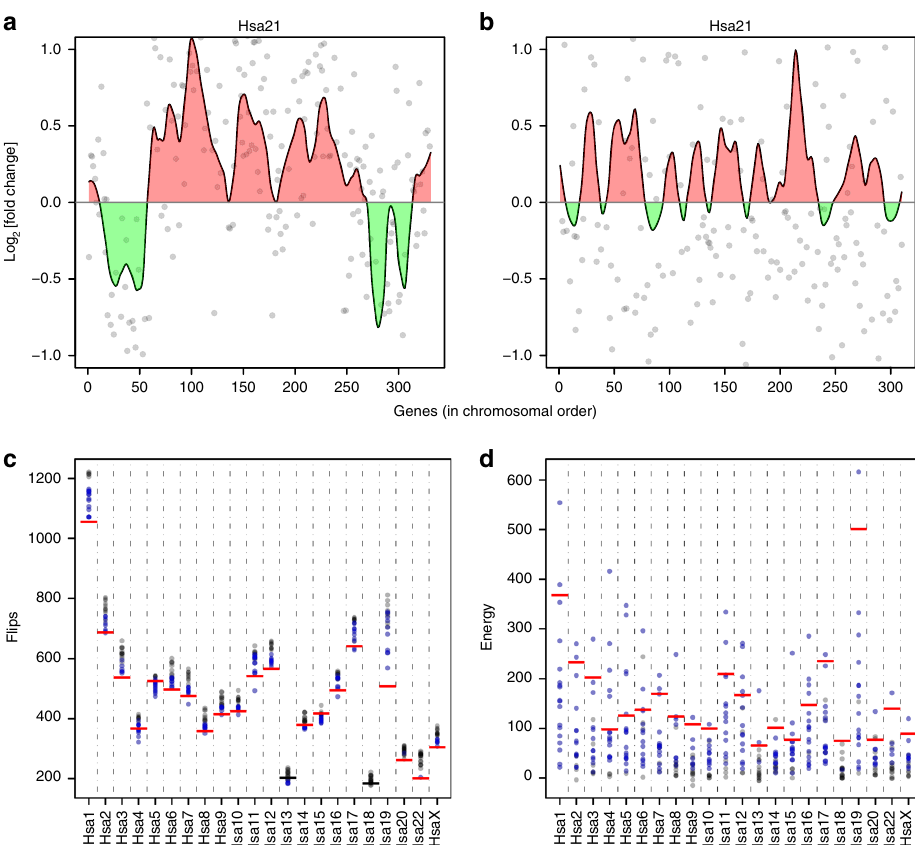
Fig. 6 Gene expression dysregulation domains do not depend on the Down syndrome (DS) genotype. a Plot showing fold change of gene expression on Hsa21 in DS vs euploid human fi broblasts 3 . Expressed genes (grey dots) are plotted in chromosomal order. A Loess smoothing curve is superimposed with regions that are upregulated or downregulated indicated in red or green, respectively. b Same as a but the fold changes are computed between two DS and two euploid samples vs between two different DS and two different euploid samples. Note apparent regions of upregulation and downregulation in this no- genotype-difference comparison. c , d Plots of fl ips ( c ) and energy ( d ) for comparisons of different combinations of DS and euploid human fi broblast samples arranged such that there is no genotype difference in the comparison. Each dot is a comparison of different combinations of samples with blue indicating combinations that are signi fi cantly different (>2 SD) from the mean of bootstrapped chromosomes and black for not signi fi cant. Horizontal lines indicate the values obtained for the correct comparison of four DS vs four euploid samples (red, signi fi cant; black, not signi fi